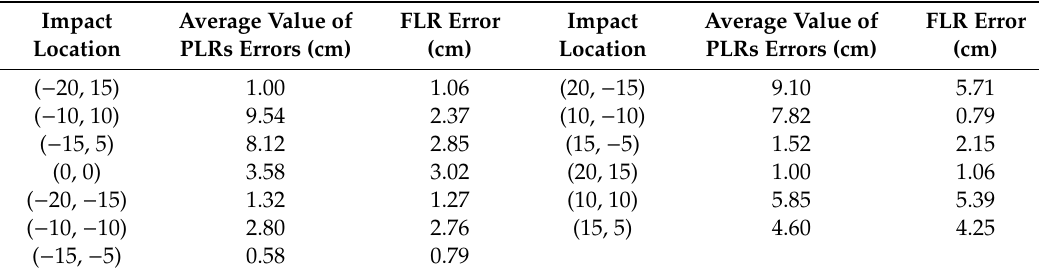
Figure 12. Impact probability map calculated by all Gaussian curves. Table 3. Final location results (FLRs) of 13 impact points.